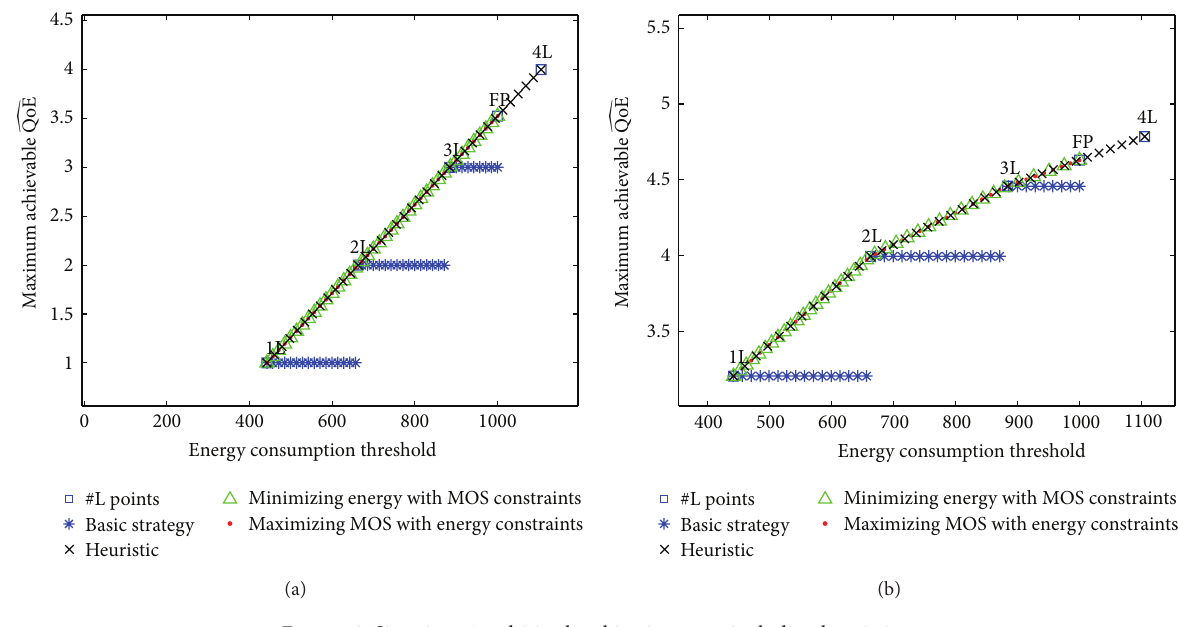
Figure 8: Situations 1 and 2 in the objective space including heuristics.